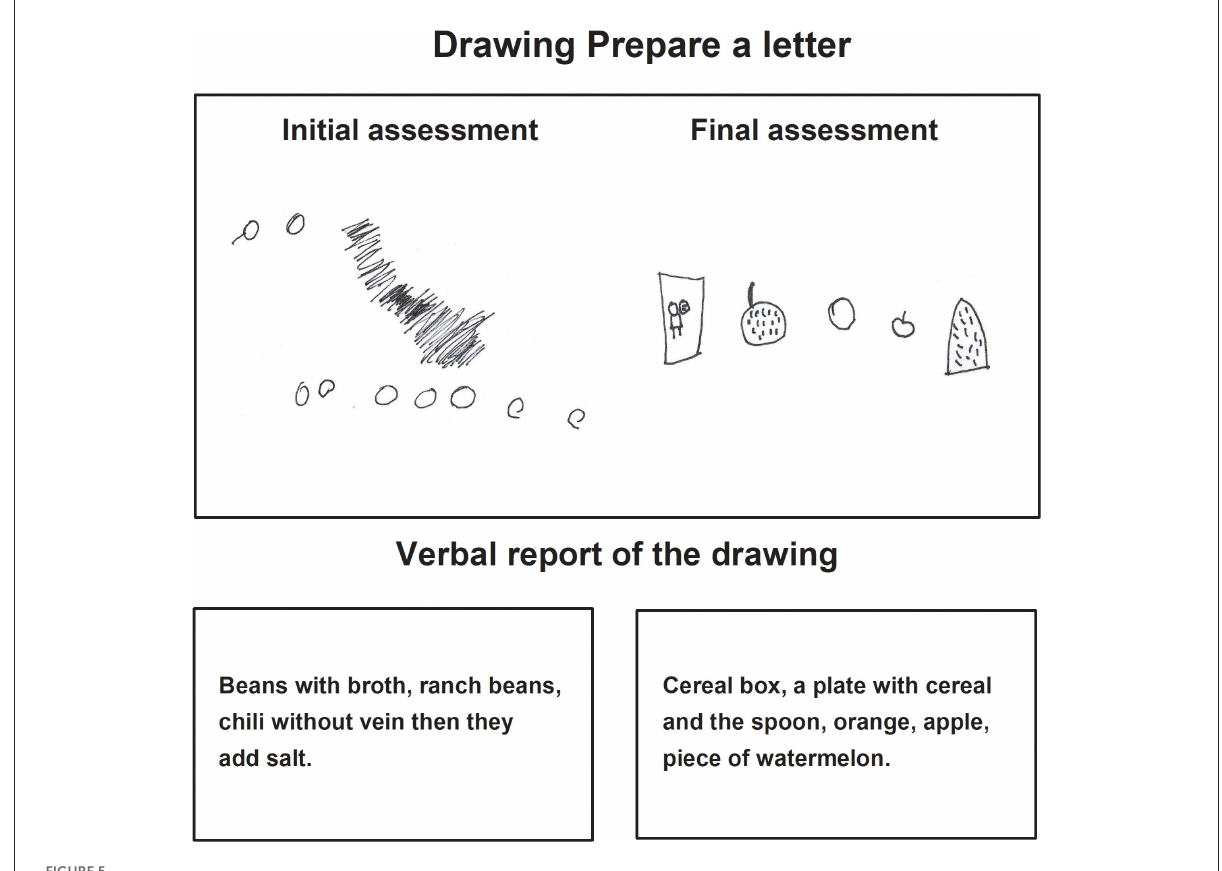
FIGURE5 Child E drawing of the task prepare a letter, during the initial and final